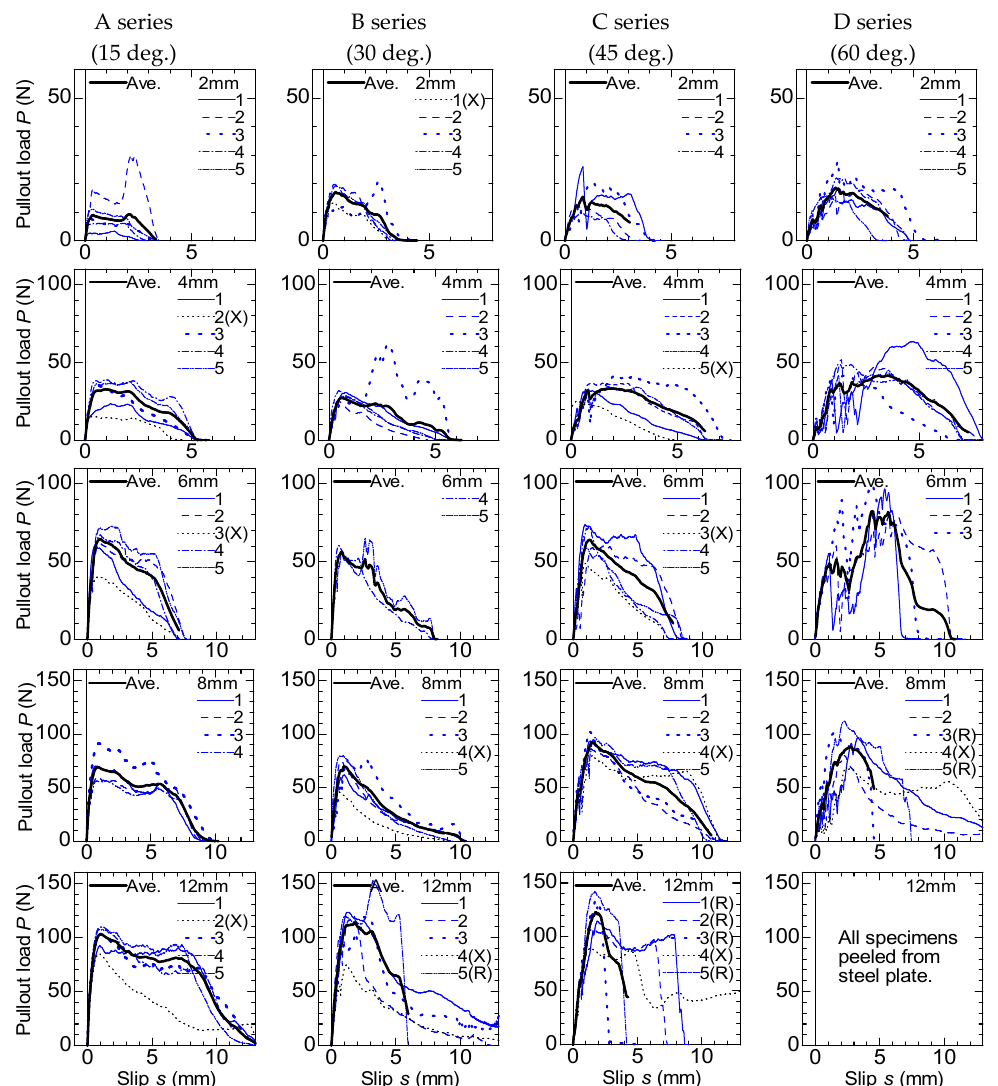
Figure 8. Pullout load–slip curve (inclined angle specimen).